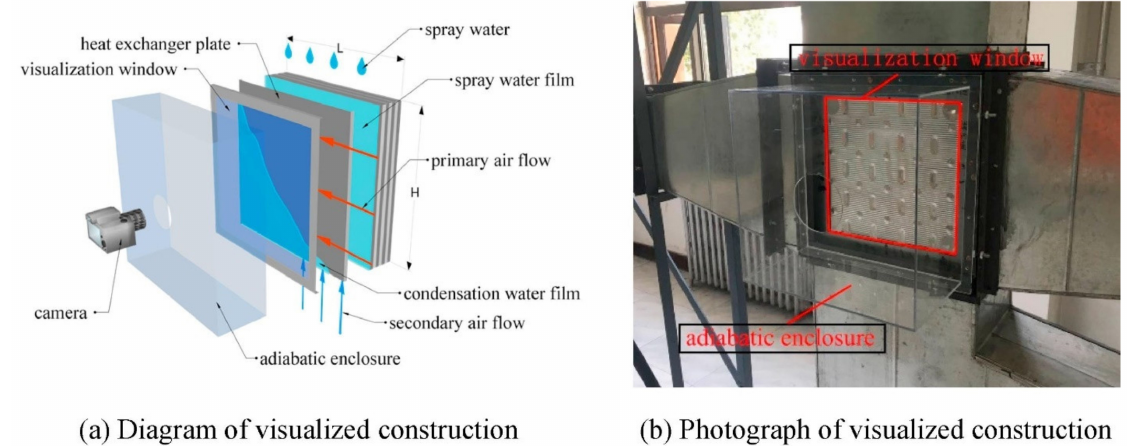
Figure 6. IEC test rig with visualization channels: ( a ) schematic diagram, and ( b ) pictorial view. Reprinted with permission from Ref. [49]. Copyright 2019,